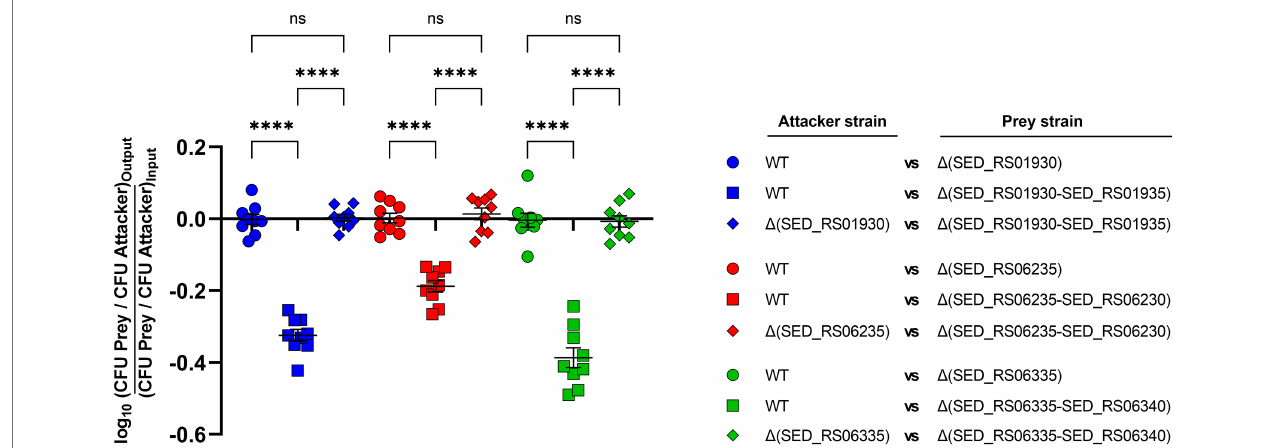
FIGURE 4 | Contribution of selected effectors and effector/immunity protein pairs to interbacterial competition in S. Dublin. Bacterial suspensions of attacker and prey strains adjusted to an OD 600nm of 0.5 were mixed at a 1:1 ratio. Then, 25 μ l of the mixture was incubated at 37 ° C for 24 h in triplicate on MacConkey agar plates. Bacterial counts recovered from each competition assay were calculated by plating serial 10-fold dilutions on LB agar plates with the appropriate antibiotics (Kan in the case of the attacker strain and Cam in the case of the prey strain). Data show the prey to attacker CFU ratio normalized to the inoculum and expressed as log 10 . Error bars indicate standard error. Statistical significance was determined using a one-way ANOVA followed by Tukey’s multiple comparisons test (**** p < 0.0001; ns, not